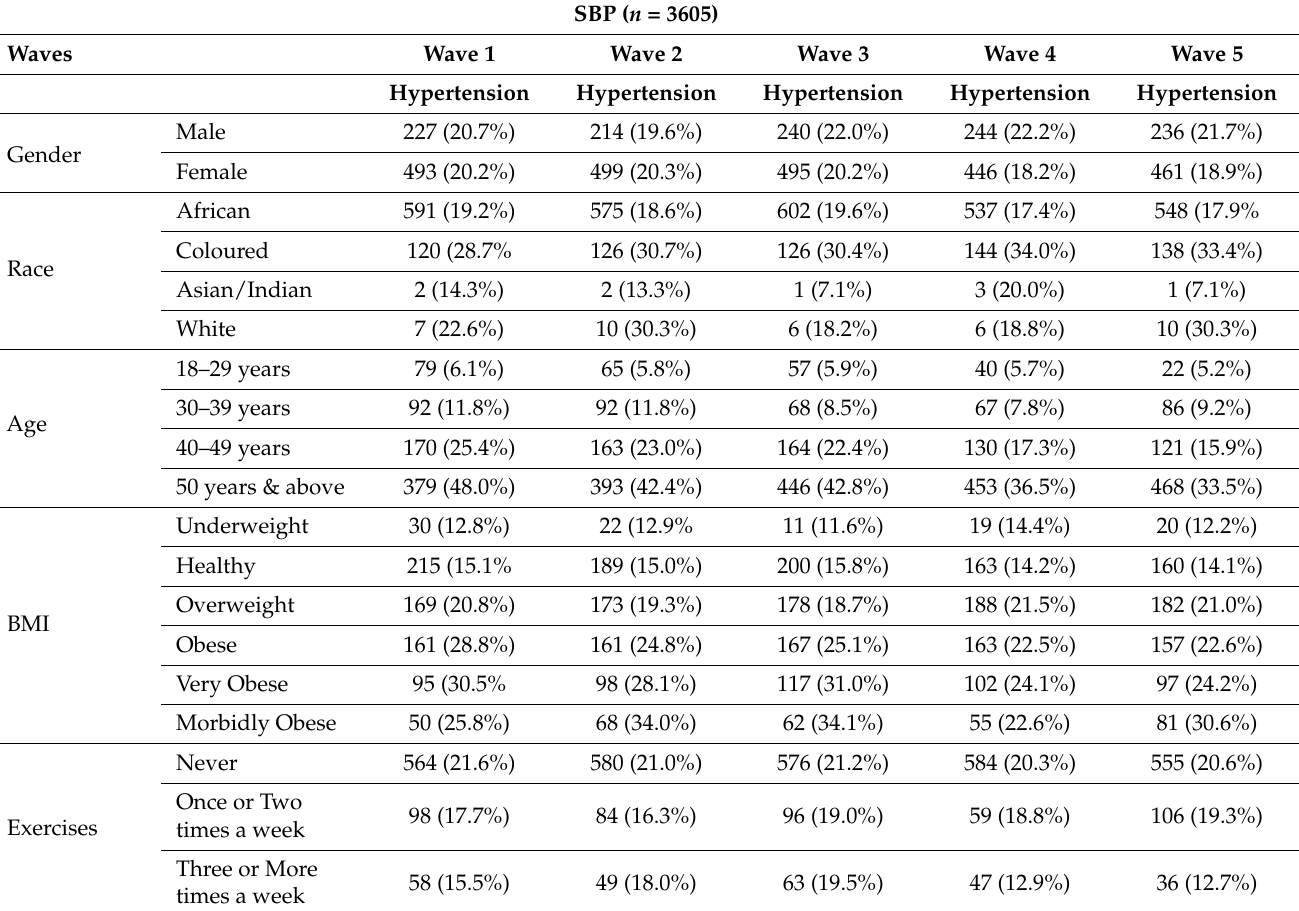
Table 3. Hypertension Prevalence among South African Adults by Demographic and Lifestyle Characteristics based on